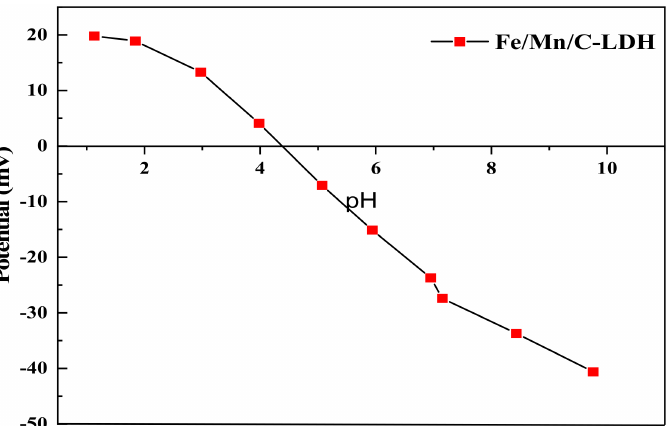
Figure 5. The Zeta potential of